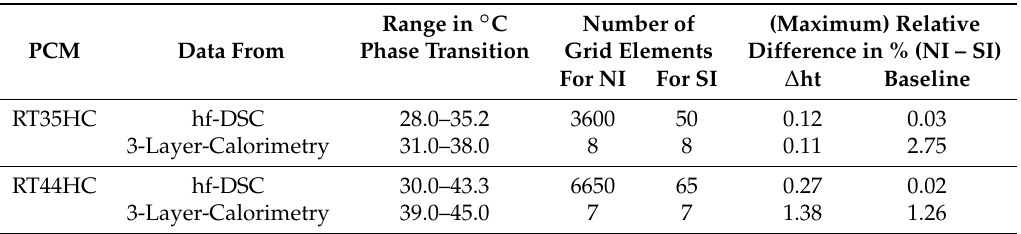
Table 1. Results from spline interpolation (SI) and from area-proportional baseline (numerical integration, NI) method.